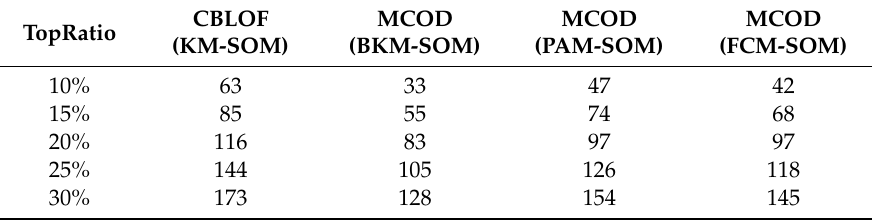
Table 9. Number of Detected Outliers for the Breast Cancer Dataset